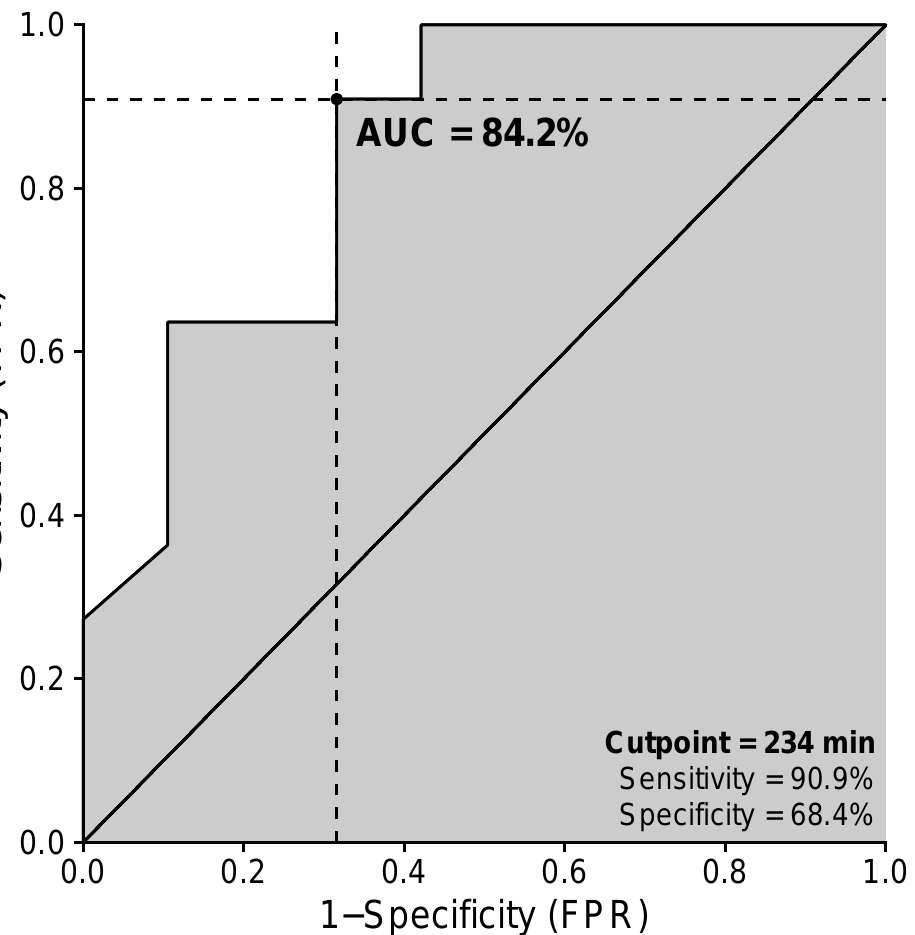
Figure 3. ROC curve of the optimal cutpoint for cervically injured patients. Note. The figure displays the respective optimal cutpoint by maximizing specificity for cervical TSCI, while sensitivity is set to a minimum of 85.0%. AUC, area under the curve; FPR, false positive rate; TPR, true positive